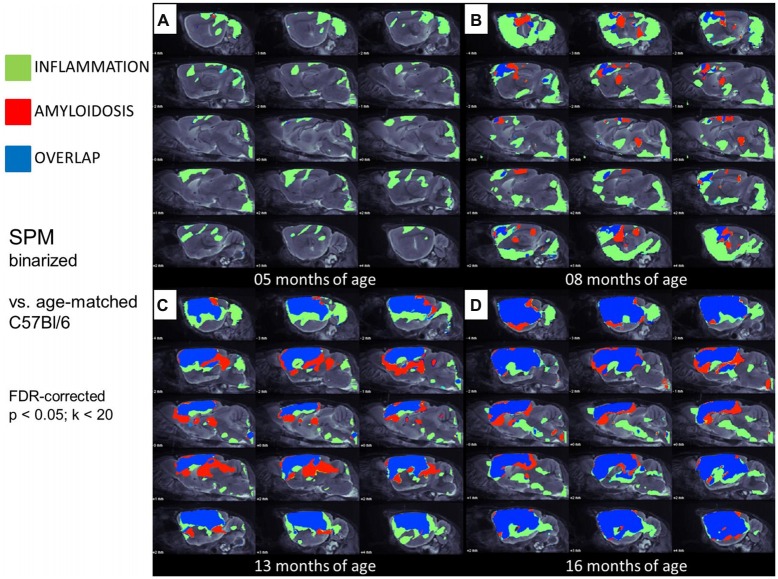
Glial activation and fibrillar amyloidosis progress regionally concerted during the life-cycle of PS2APP mice. (A–D) Voxel-wise regional distribution of elevated in vivo radiotracer uptake in PS2APP mice compared to WT at all four different age stages. Increases in TSPO [18F]-GE180 μPET binding, indicating glial activation (green), increases in amyloid [18F]-florbetaben μPET binding (red), and areas of overlapping increases for both radiotracers (blue) are projected upon sagittal slices of an MRI mouse atlas. Data information: in (A–D) all voxels of the mouse brain were compared by a student’s t-test in SPM. All significant differences exceeding a threshold of p < 0.05, including FDR-correction for multiple comparisons were binarized for each tracer.